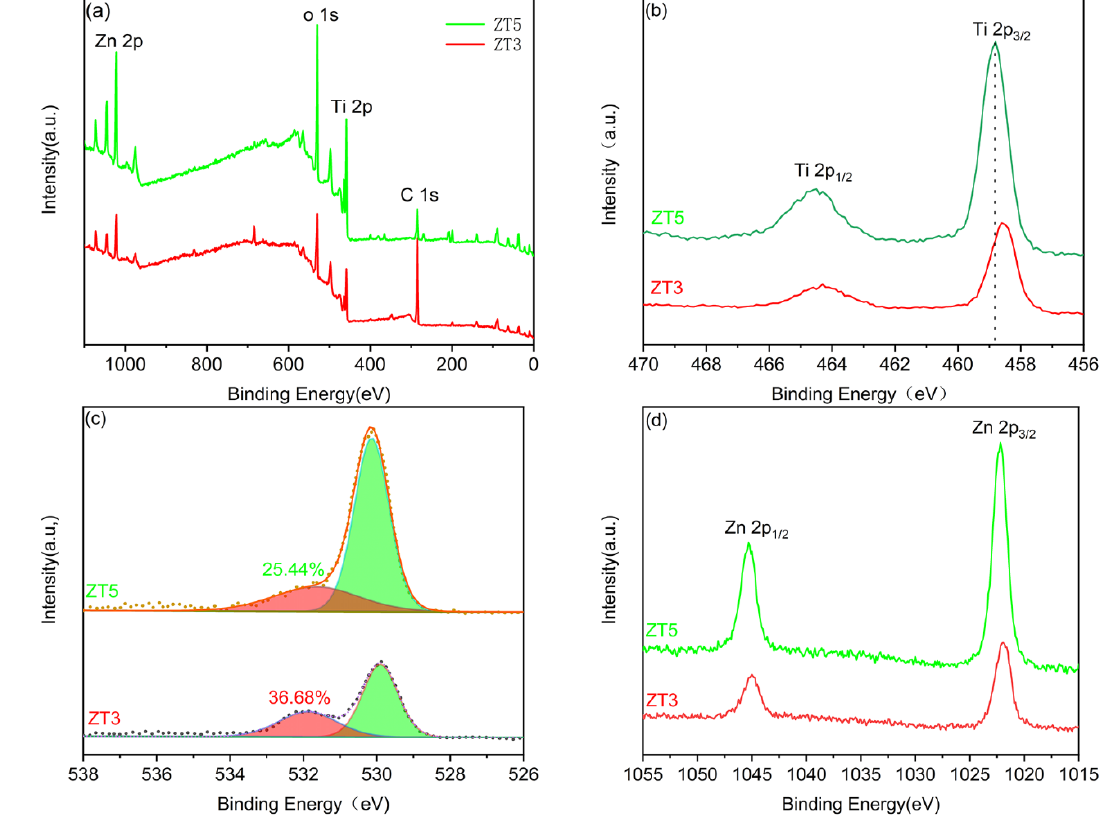
Figure 6. ( a ) Survey spectra; ( b ) Ti 2p; ( c ) O1s; and ( d ) Zn 3d XPS spectra of as-prepared samples.